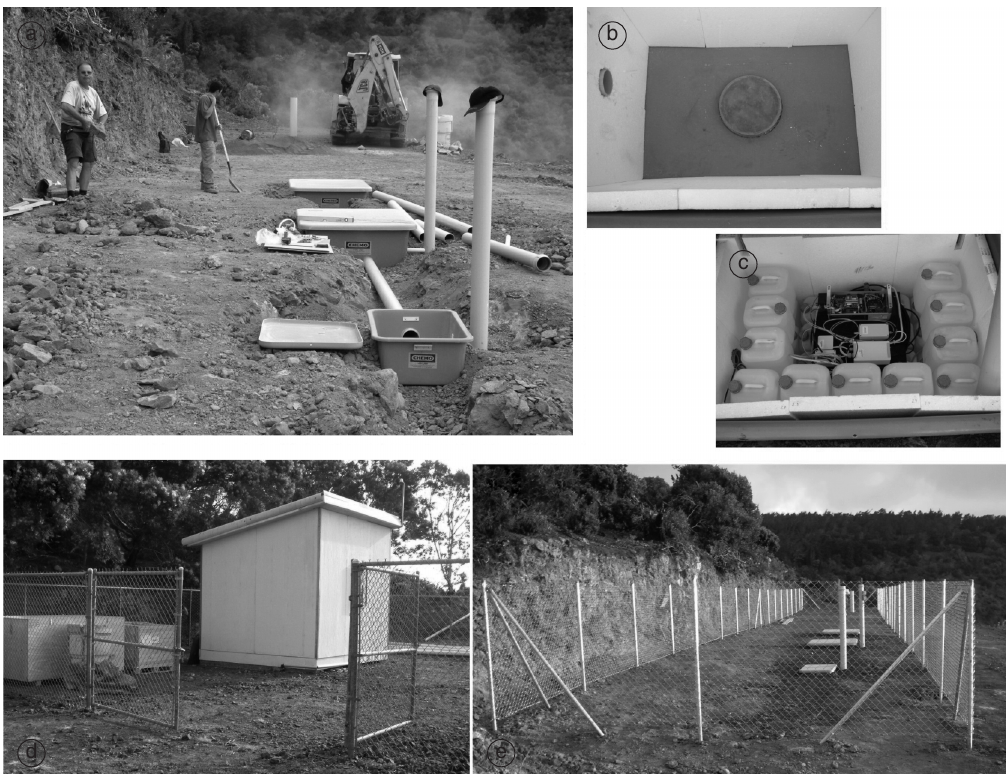
Fig. 8a-e. The new STH observatory. a) Installation of the plastic containers for recording equipment with ca- ble trenches. b) FGE magnetometer sensor pillar in one of the containers, lined with styrofoam for thermal in- sulation. c) FGE electronics unit in another container, already partly surrounded by water cans for further ther- mal insulation. d) Computer building of the IDA seismological station, which now also houses the geomagnet- ic observatory computers. e) Overview over the observatory premises just after installation had been